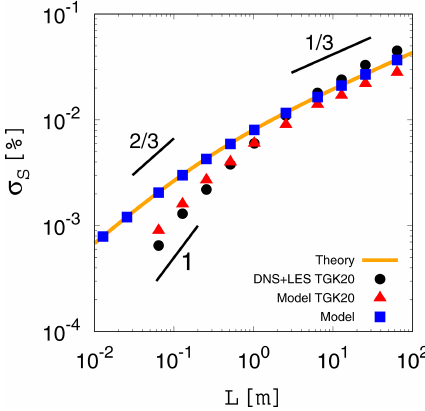
Figure 1. Standard deviation of the supersaturation fluctuation σ S (cid:48) in the statistically steady state obtained from the analytical expres- sion given by Eq. (13) (orange curve) and the results of our numeri- cal integration of the original version of the eddy-hopping model (blue squares). The horizontal axis is the integral length L . The black dots indicate the reference data taken from direct numerical simulations and large-eddy simulations by Thomas et al. (2020). The red triangles indicate the results of the numerical integration of the original version reported by Thomas et al. (2020). The range of L and σ S (cid:48) for the panel is the same as in Fig. 10 in Thomas et al. (2020). The three short black lines indicate slopes of 1, 2 / 3, and 1 /